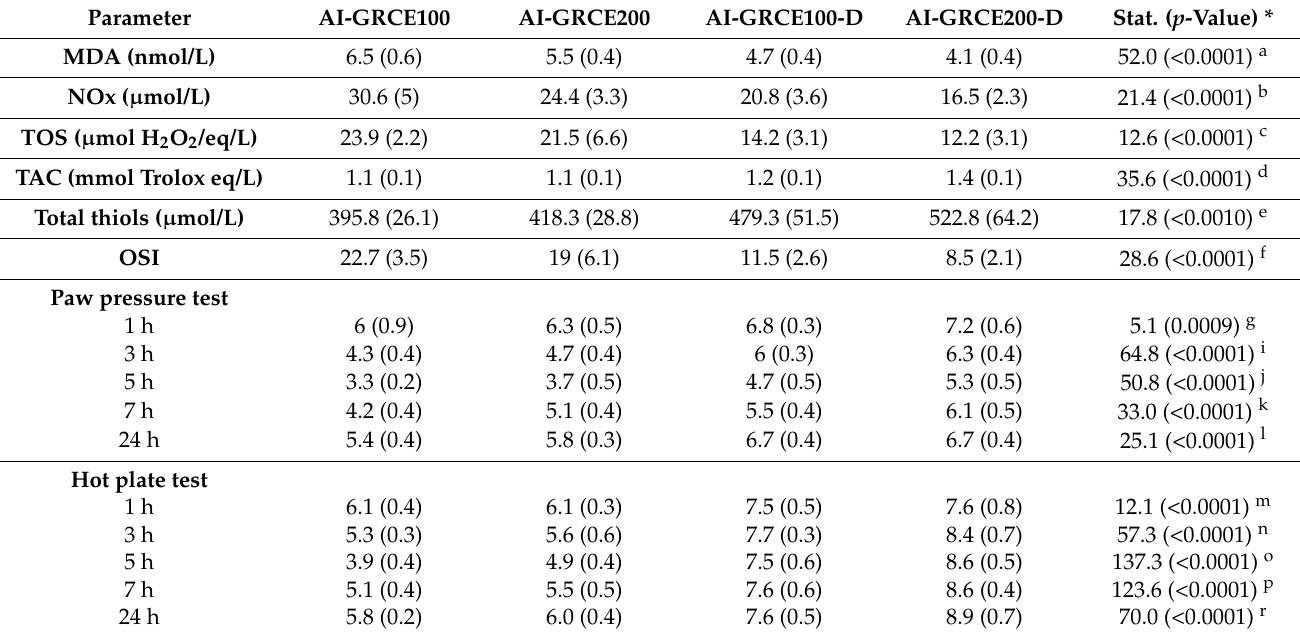
Table 6. Serum levels of evaluated biomarkers, paw pressure and hot plate tests for the control with GRCE and GRCE-D and comparison between all